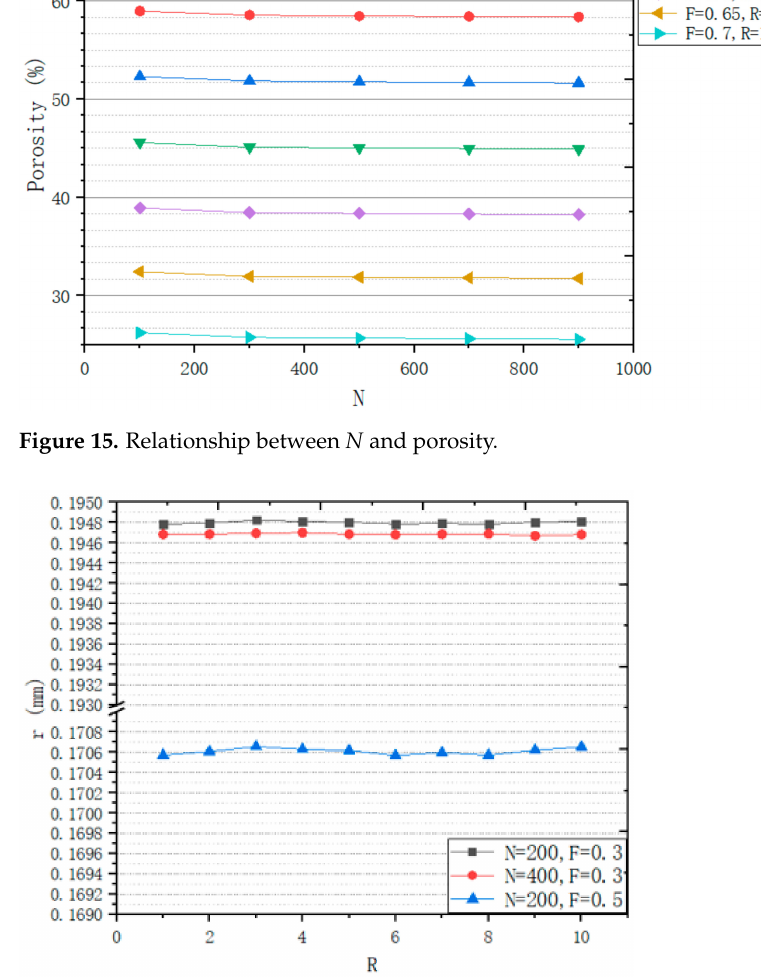
Figure 16. Relationship between R and r.